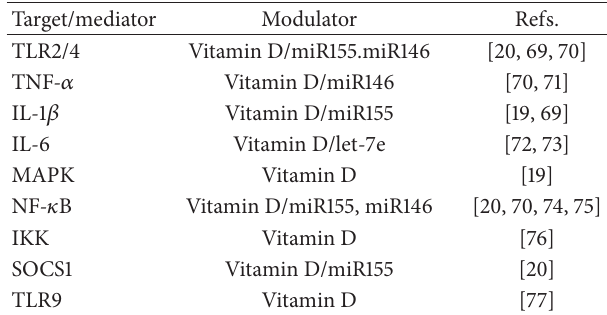
Table 3: Vitamin D and miR targets associated with inflammatory